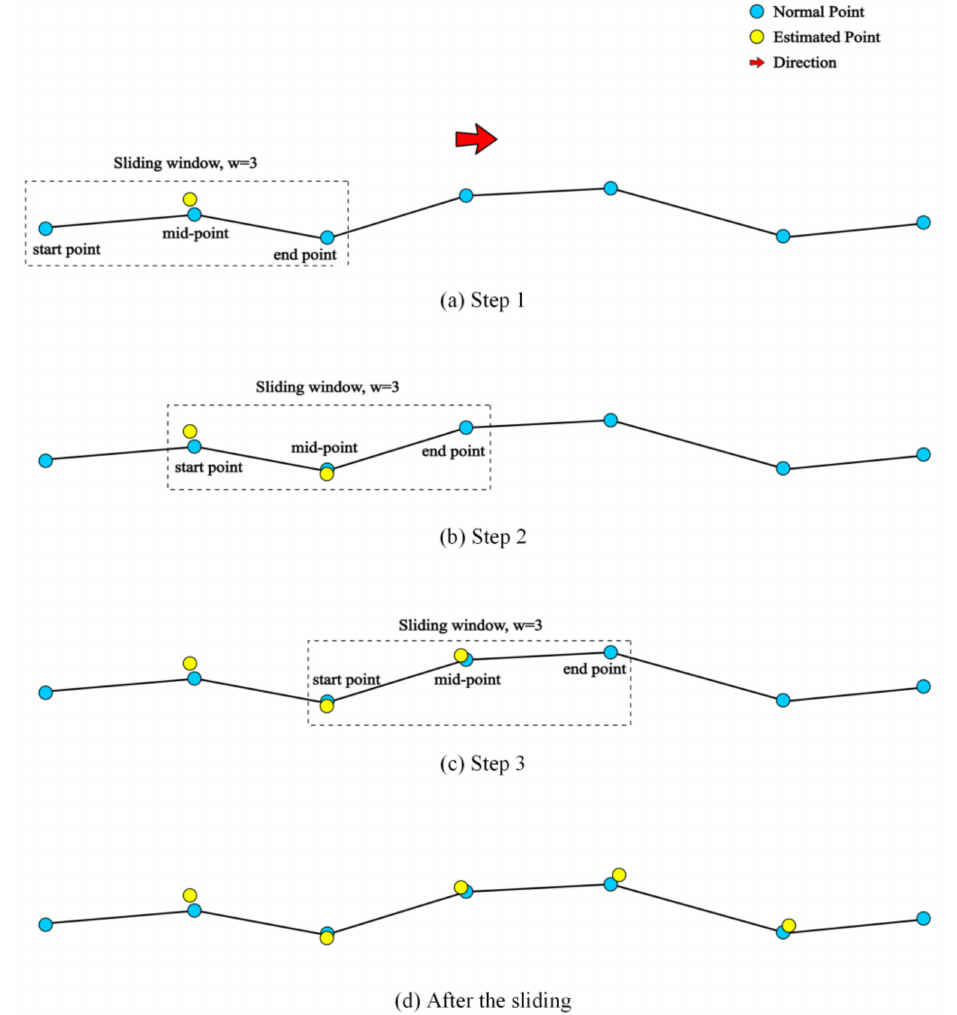
Figure 3. Principle of kinematic estimation for anomaly